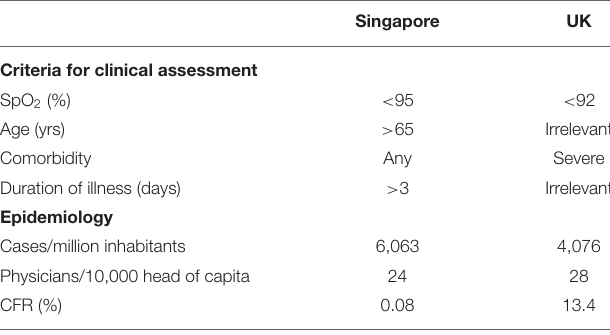
TABLE 2 | Comparison of the criteria for assessment in suspected or confirmed COVID-19 between Singapore and the UK.